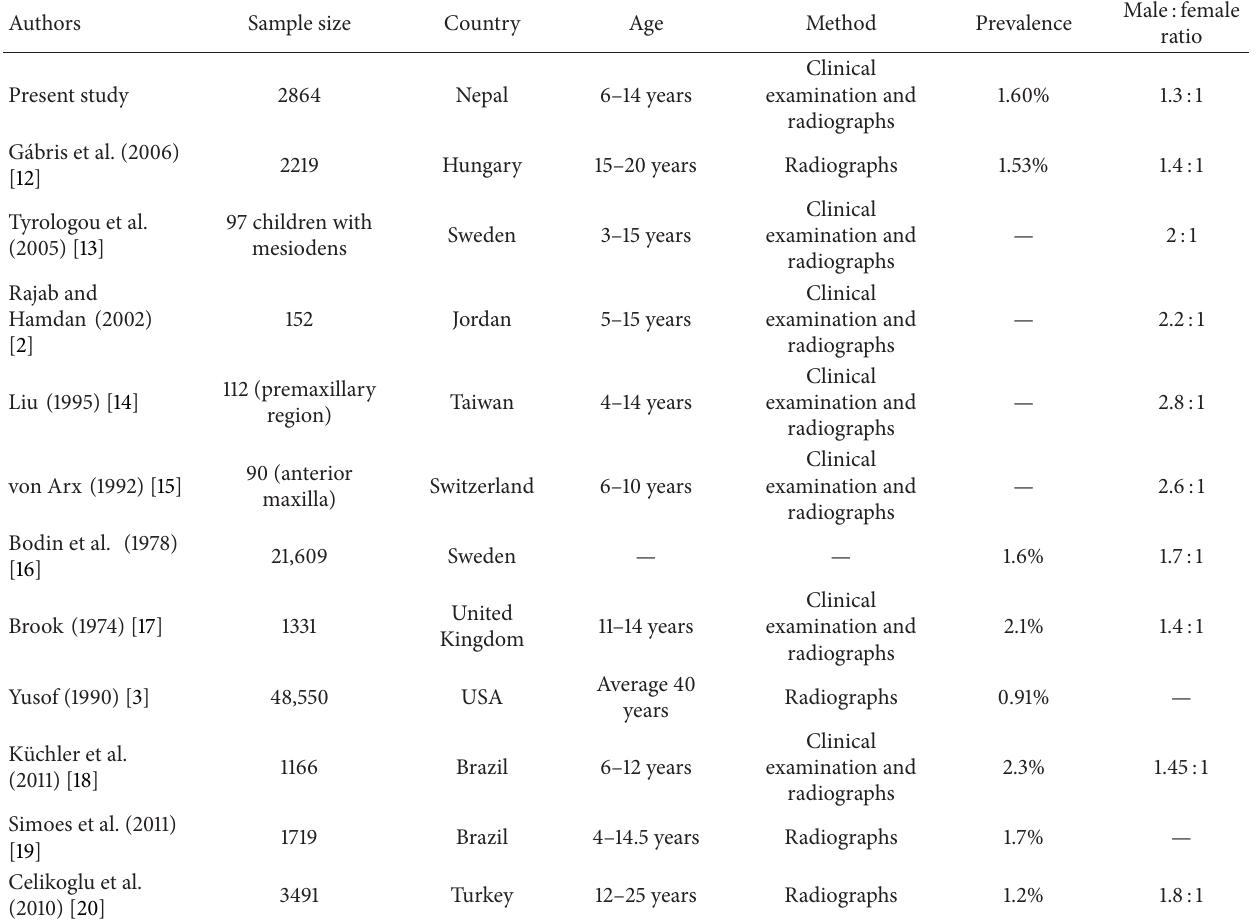
Table 3: Summary of various studies carried out on supernumerary teeth in different